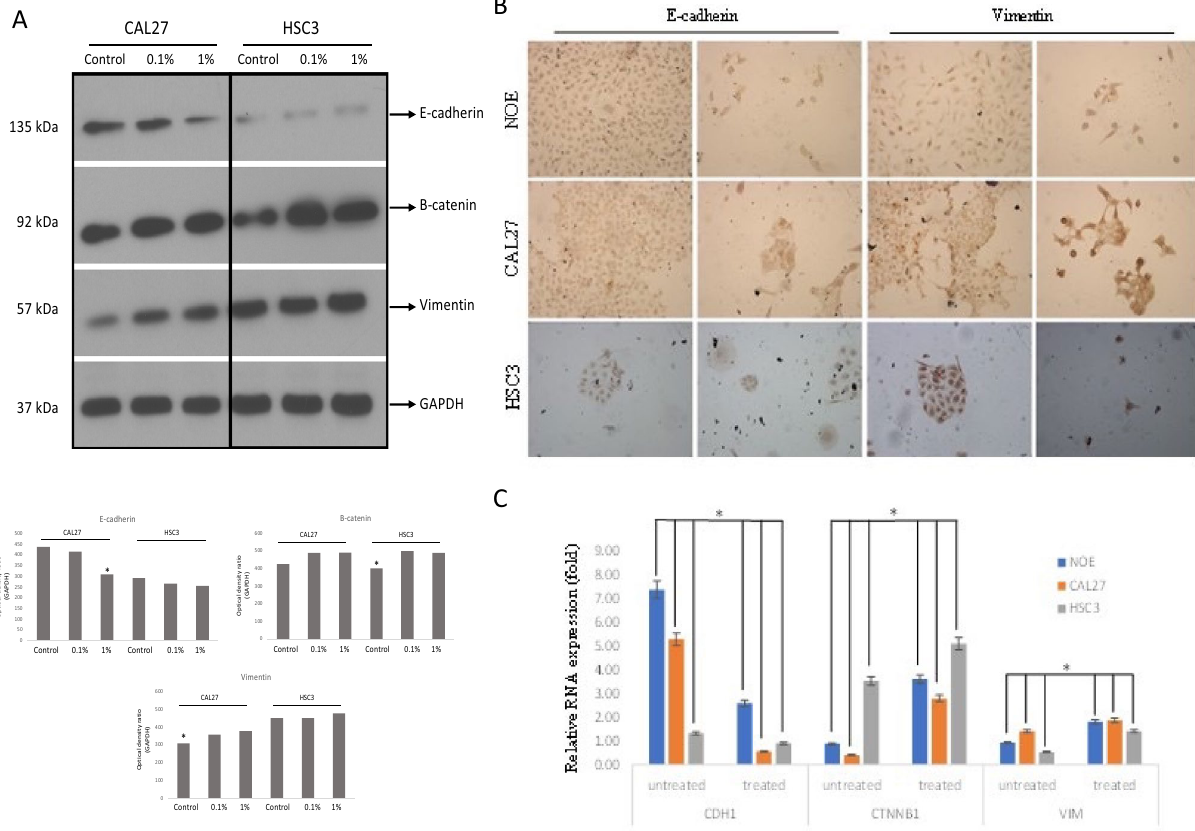
Figure 4. E-liquid induced epithelial to mesenchymal transition (EMT) in normal epithelium oral cells and OSCC. ( A ) Treatment with 0.1% and 1% of e-liquid induced down-regulation of epithelial markers E-cadherin, whereas it caused concomitant increase of mesenchymal proteins and B-catenin and vimentin in CAL27 and HSC3 human OSCC cell lines. GAPDH was used as the control for the assay. Original gels/blots are used in figures are available in the supplementary material provided to the journal. ( B ) Immunocytochemistry reaction showing changes in morphology before and after treatment with 1% e-liquid in normal epithelial cells (NOE) and OSCC cell lines (CAL27 and HSC3). ( C ) Quantitative RT-PCR (q-RT-PCR) showing that gene expression for CDH1 , CTNNB1 and VIM had a significant difference after e-liquid treatment. GAPDH , HPRT , and ACTB were used as reference genes. * P <